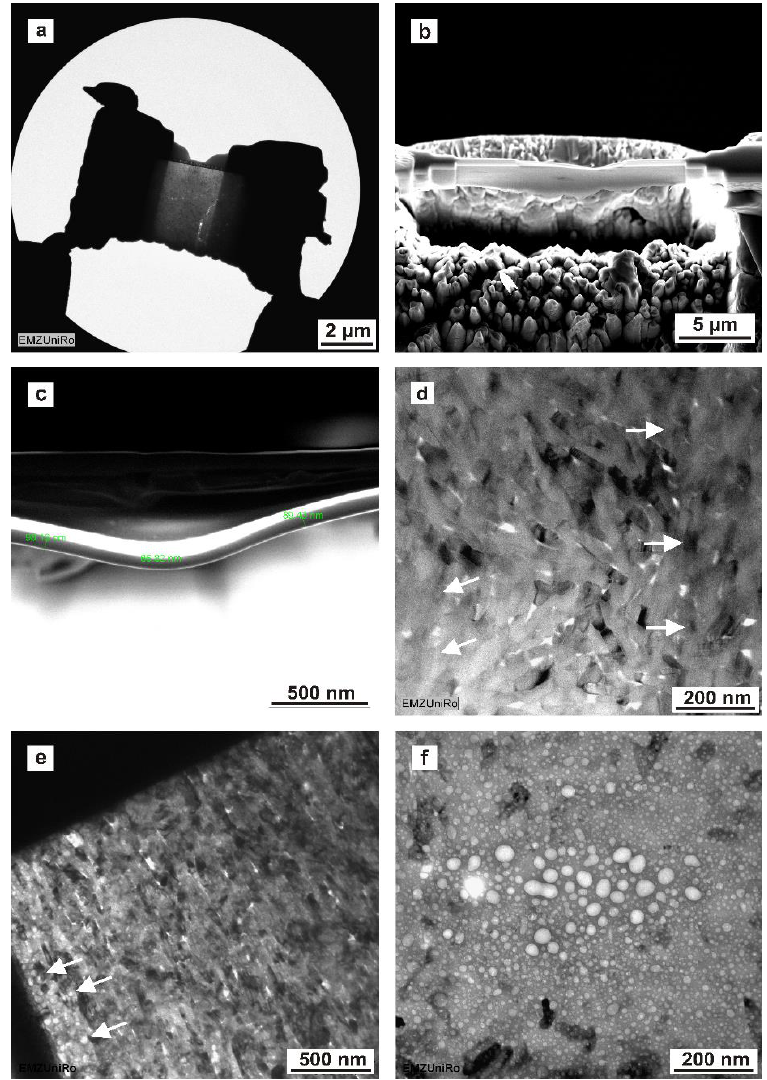
Figure 8. Enamel and dentine sections depicting FIB and electron-beam-induced artefacts. ( a ) TEM image of an FIB-prepared enamel lamella. ( b ) SEM micrograph of an FIB-prepared dentine section depicting FIB/TEM – lamella bending. ( c ) SEM micrograph of FIB-prepared dentine showing en-